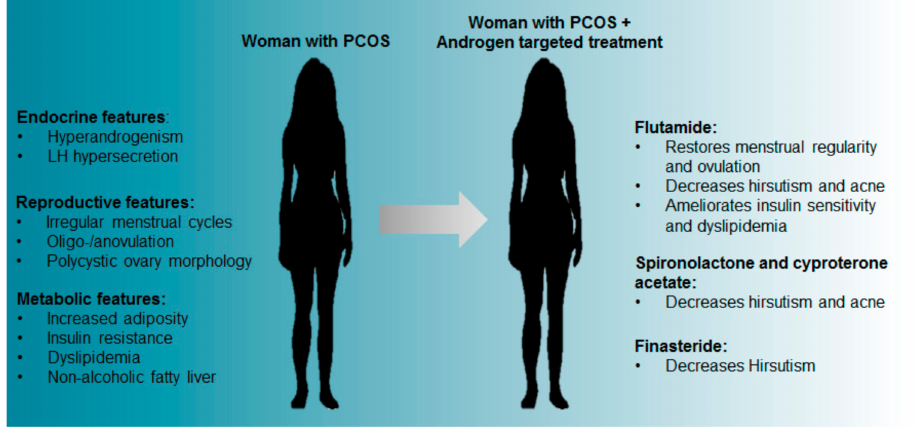
Figure 1. PCOS features and the reported e ff ects of androgen blocking treatments in women with PCOS. Alternative anti-androgens include spironolactone and cyproterone acetate, steroidal AR blockers that compete with T and DHT for binding the AR. Both of these AR blockers are observed to